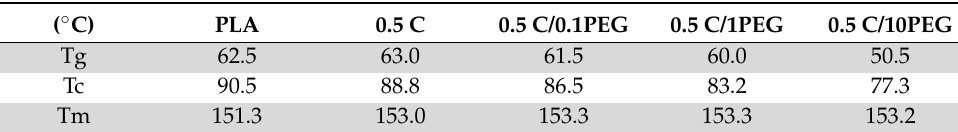
Table 5. Tg, Tc, and Tm of nanofibers determined by DSC